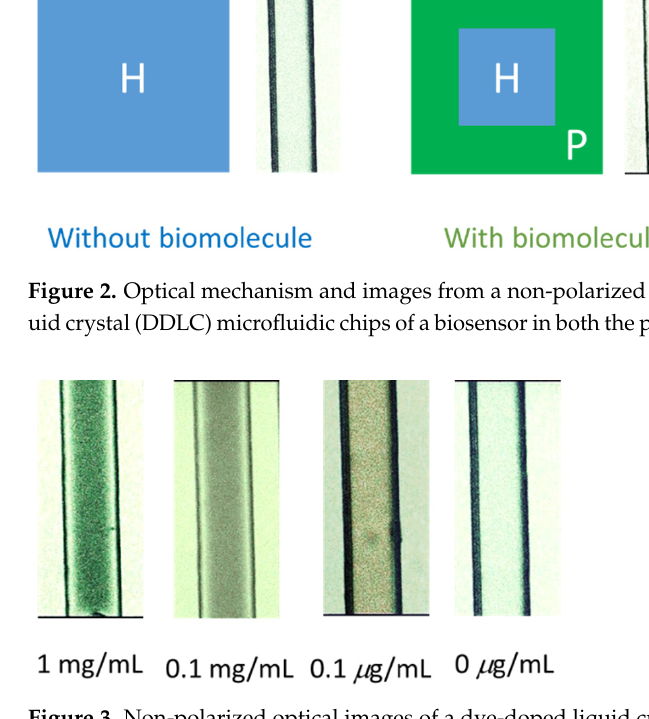
Figure 3. Non-polarized optical images of a dye-doped liquid crystal (DDLC) microfluidic biosensor. The bovine serum albumin (BSA) immobilized at concentrations 0~1 mg/mL.